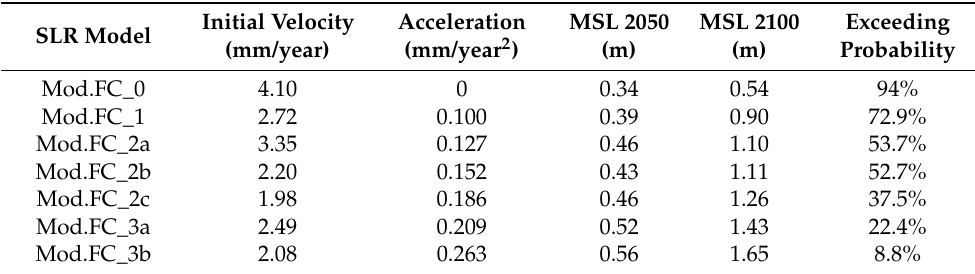
Table 4. Set of relative empirical SLR models for the WCPM, velocity and acceleration parameters, MSL projections for the middle (2050) and the end of the century (2100), and the respective exceeding probability at epoch